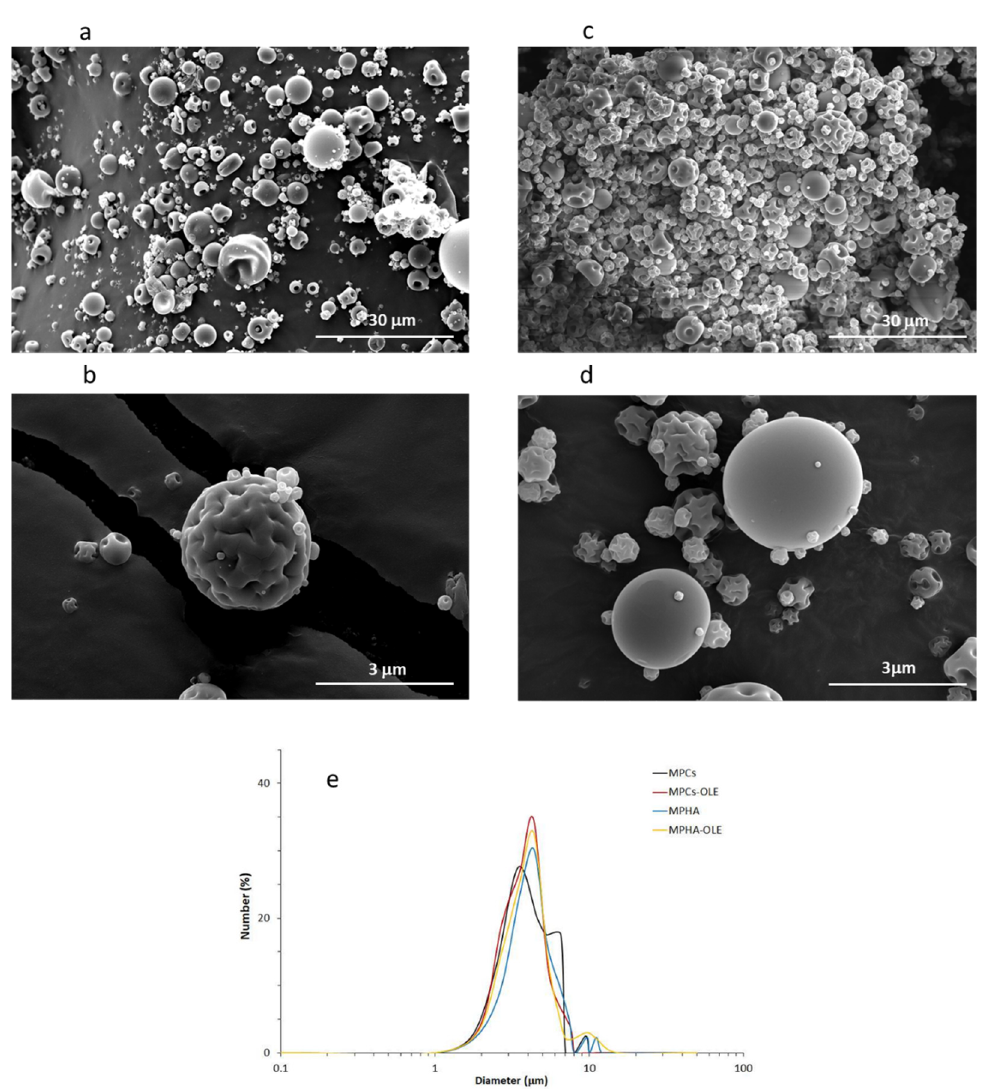
Figure 2. SEM micrographs of ( a ) MPHA; ( b ) MPHA-OLE; ( c ) MPCs; ( d ) MPCs-OLE; ( e ) Number (%) vs. diameter size distribution curves of MP.